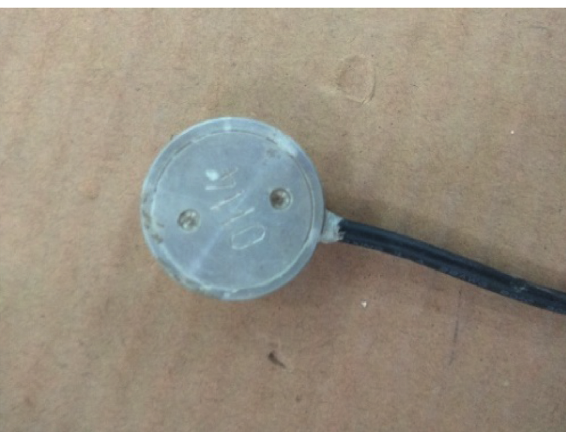
Figure 1: Miniature Earth pressure cell.